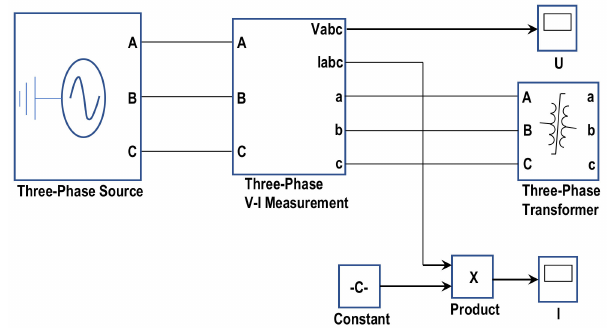
Figure 3. Excitation circuit of transformer under no-load condition.